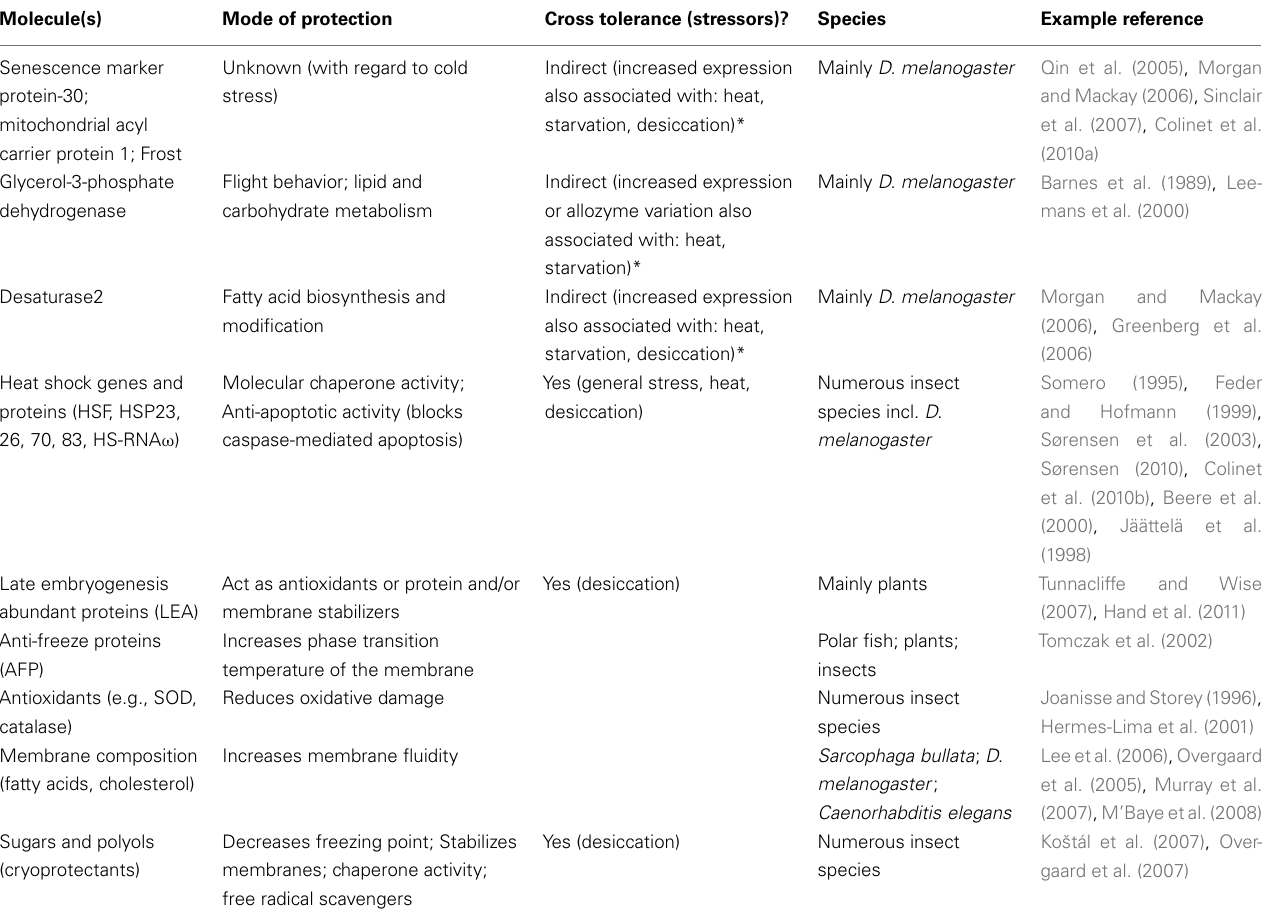
Table 2 |A summary of mechanisms of insect low temperatures